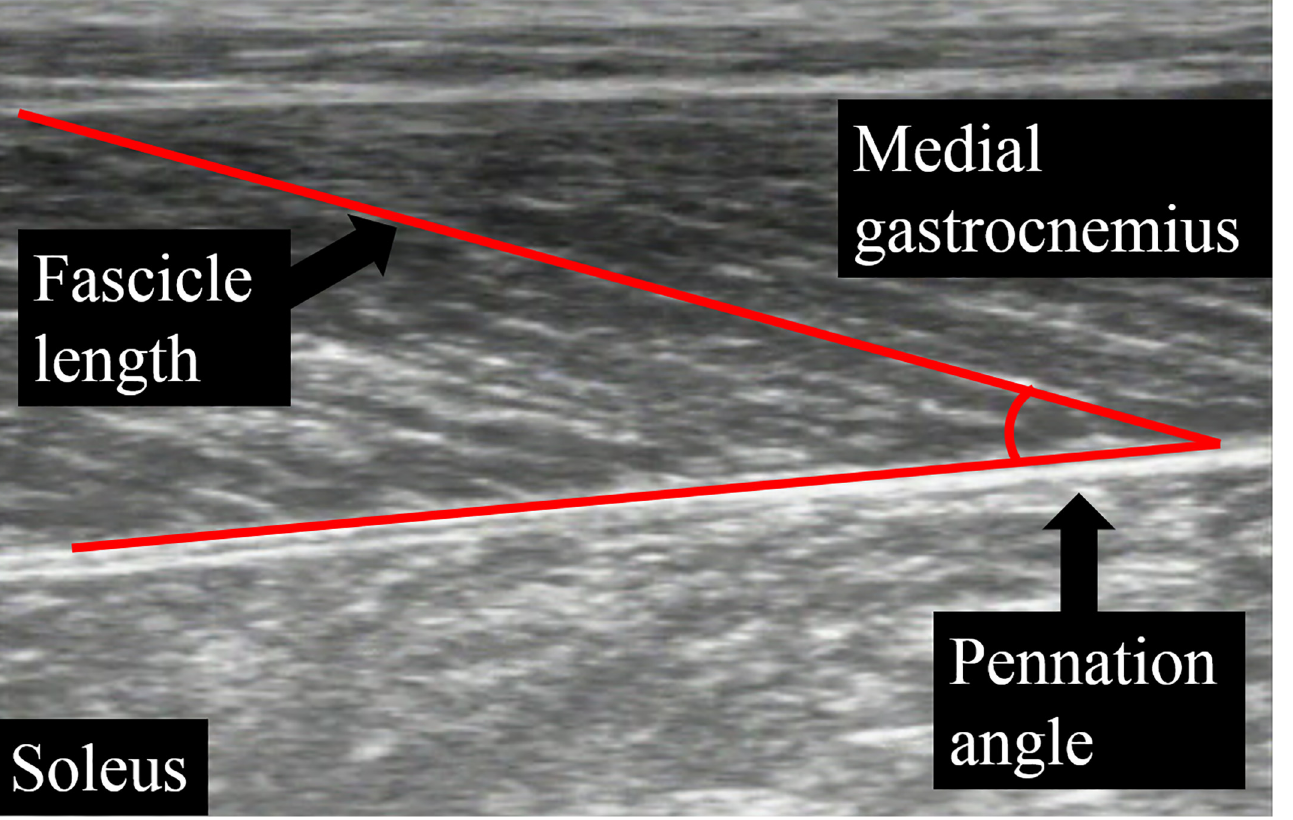
Fig 3. Analyses of fascicle length and pennation